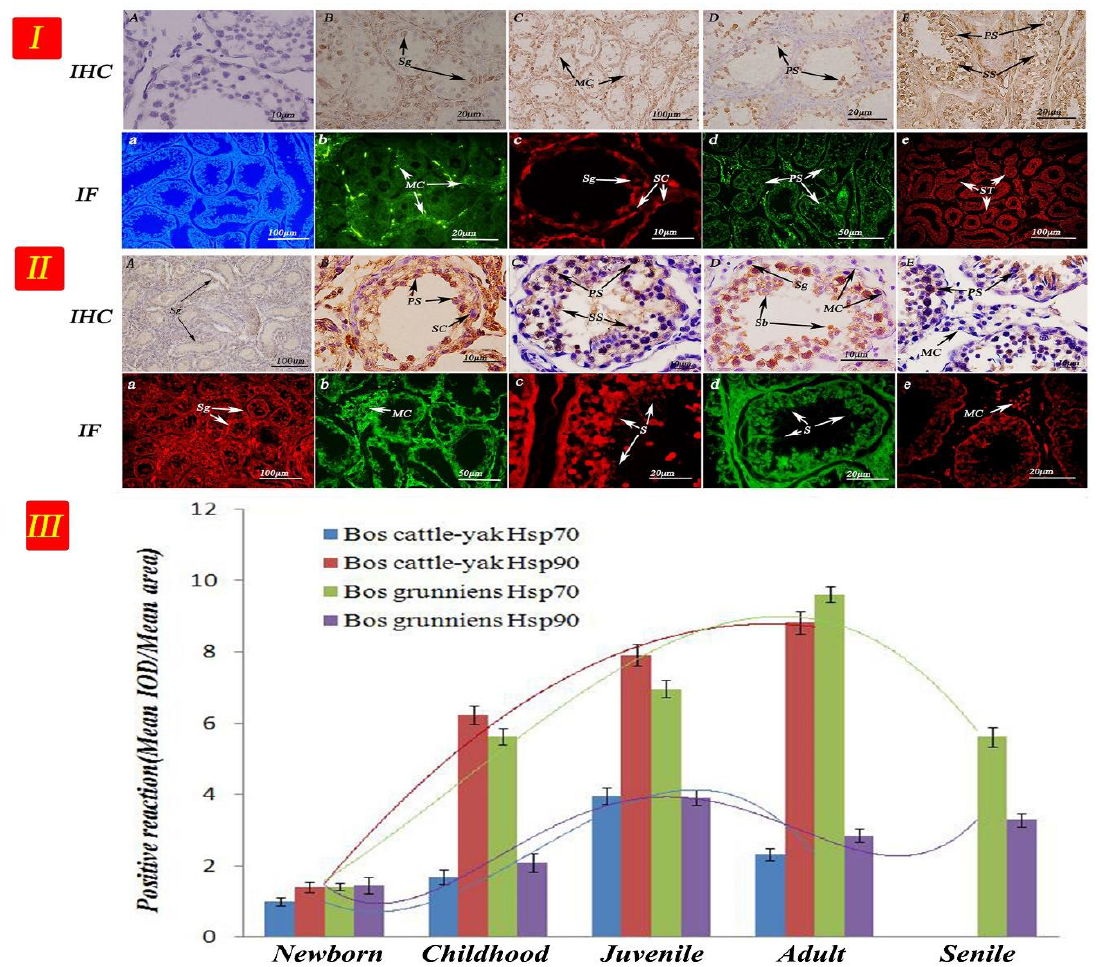
Figure 7. IHC and IF expression of Hsp70 and Hsp90 in testicular tissues from cattle – yak and yak. The arrow represents the site of positive expression. IHC(A,B,C,D,E) and IF(a,b,c,d,e). ( I ) Cattle-yak: (A) Control section from testicular tissue of adult yak, without immunoreactions (negative control). (B), (D) Positive staining for Hsp70 was observed in spermatogonium and primary sper- matocyte of newborn and juvenile testis. (C), (E) Positive staining for Hsp90 was observed in mesenchymal, primary spermatocyte, and secondary spermatocyte cells of testes from childhood and adulthood. (a) Control section from testicular tissue of adult yak, without immunoreactions (negative control). (b), (d) Positive staining for Hsp90 was observed in the mesenchymal cells and primary spermatocyte of newborn and adult testis. (c), (e) Positive staining for Hsp70 was ob- served in spermatogonium, Sertoli cells, and seminiferous tubule of testes from childhood and adulthood. ( II ) Yak: (A), (C), (E) Positive staining for Hsp90 was observed in spermatogonium,